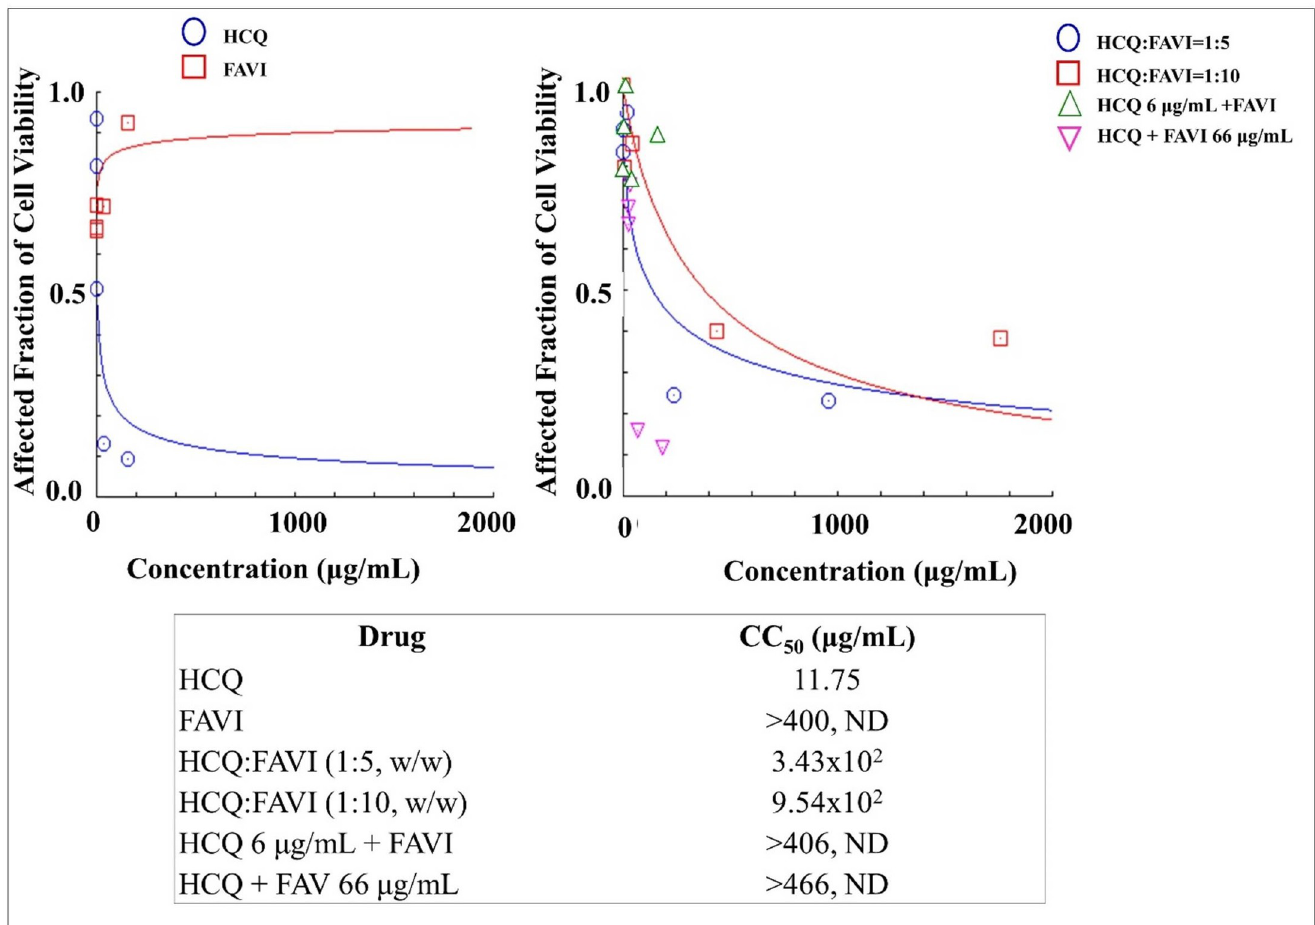
Fig 10. The cytotoxicities of Hydroxychloroquine (HCQ) and Favipiravir (FAVI) as a single drug (left) and dual drug combination in constant and non- constant ratios (right) analysed by using CompuSyn Software (n = 3). At non-constant ratios of HCQ 6 μ g/mL + FAVI, HCQ was added at a concentration of 66 μ g/mL to each increased levels of FAVI i.e. 0.2, 2, 10, 100, and 400 μ g/mL. On the other hand, FAVI was then added at a concentration of 66 μ g/mL to each increased levels of HCQ i.e. 0.2, 2, 10, 100, and 400 μ g/mL to produce HCQ + FAVI 66 μ